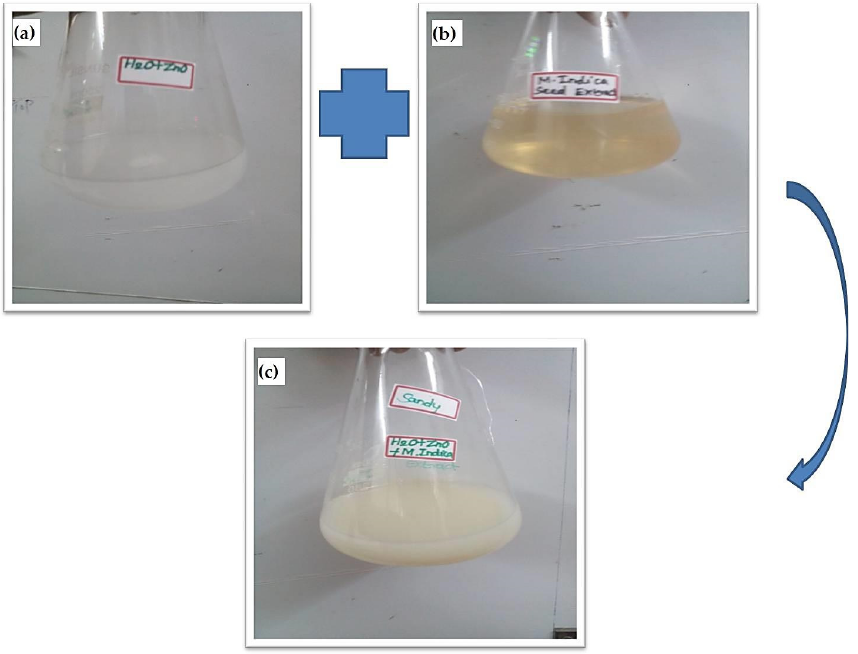
Figure 10. M. indica seed extract-based ZnO NP synthesis. ( a ) 10 mM Zinc nitrate precursor solution ( b ) M. indica seed extract ( c ) M. indica seed extract combined with Zinc nitrate precursor solution.